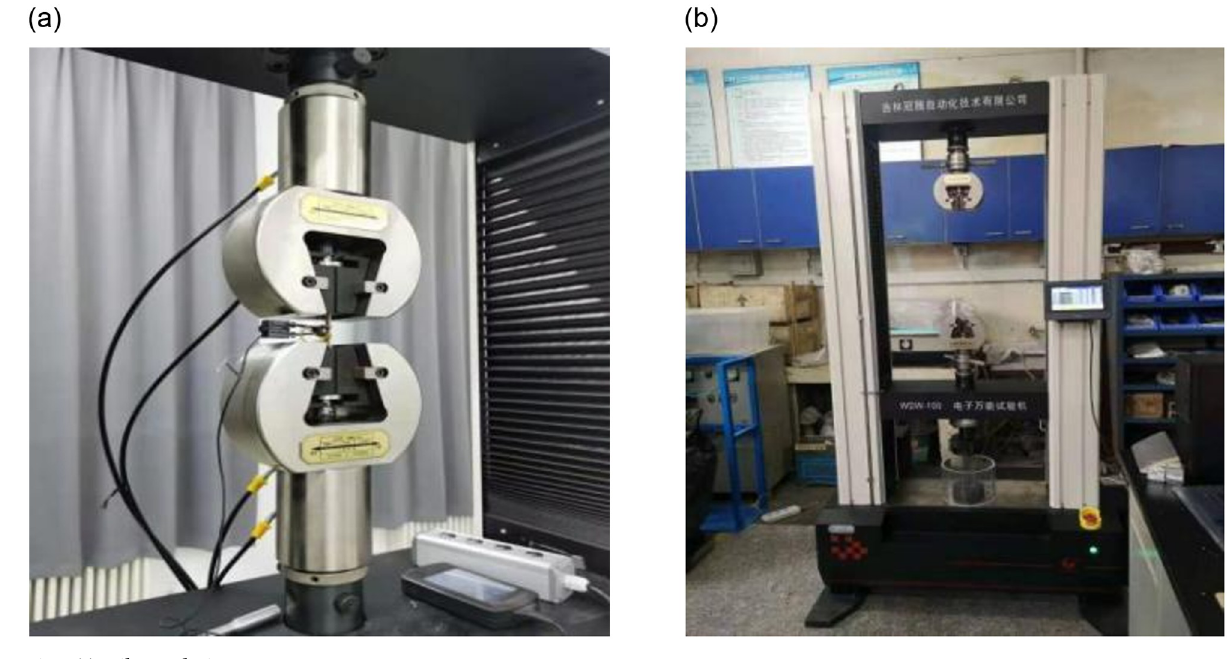
Fig 2. Tensile test device.